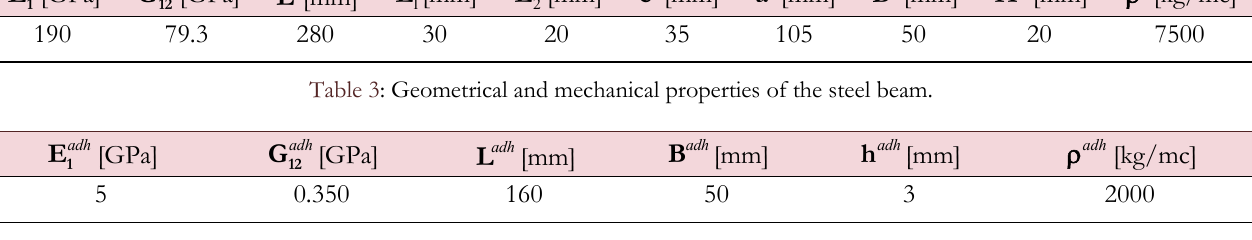
Table 4: Geometrical and mechanical properties of the adhesive layer.